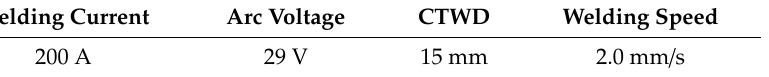
Figure 7. Interaction of welding speed and arc voltage on welding spatter.